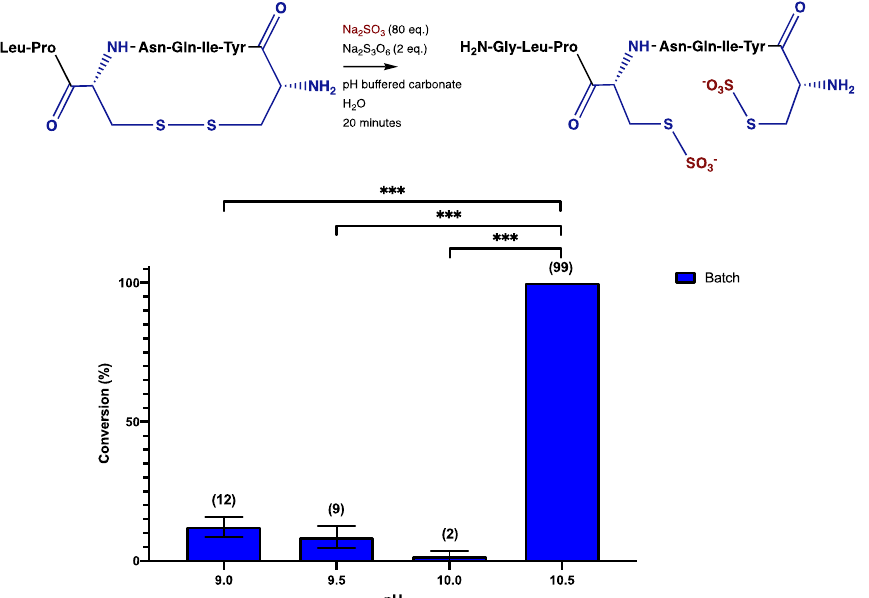
Figure 3. Oxidative sulfitolysis of oxytocin. Above is a schematic of the sulfitolysis reaction with oxytocin. Comparisons between batch performed in carbonate buffered at pH of 9, 9.5, 10, and 10.5; conversions were determined using HPLC with percent conversion determined by comparing areas under the curve for reduced and sulfitolysed oxytocin. Significance is reported as ns (not significant), * ( p < 0.01), ** ( p < 0.001), or *** ( p < 0.0001). All experiments were repeated in triplicate.